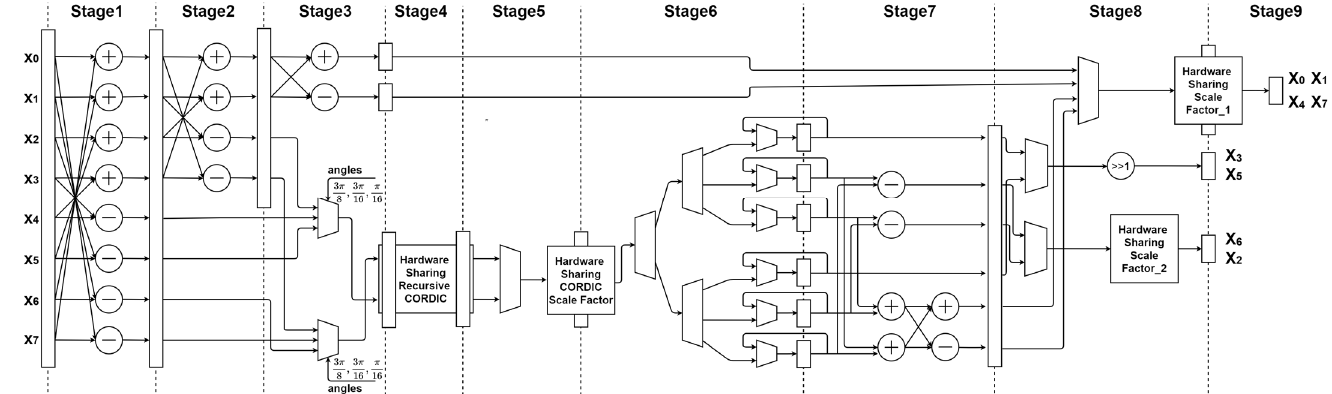
Figure 6. Very large scale integration (VLSI) architecture of the proposed 9-stage pipeline 1-D DCT circuit. Table 1 lists an efficient and high precision way to develop a scaling factor generator.